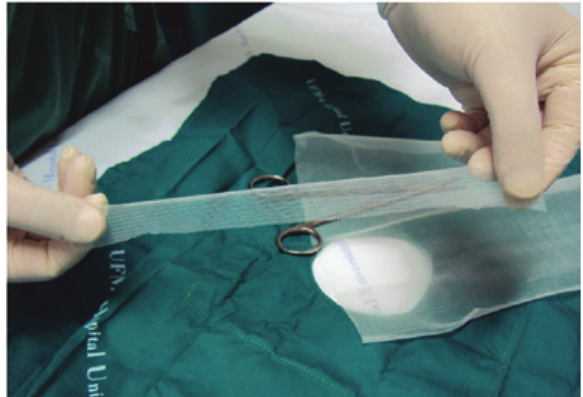
Figure 1 - Making the hand-made polypropylene sling for surgery.